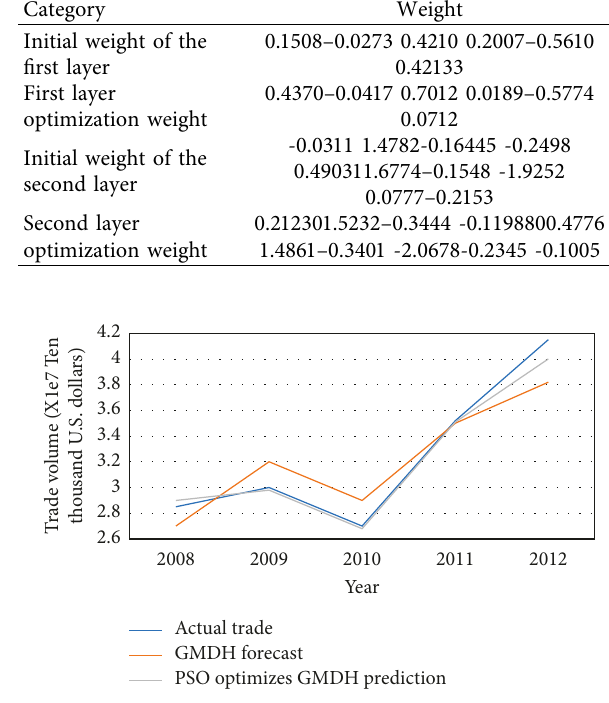
Figure 6: PSO-optimized GMDH network